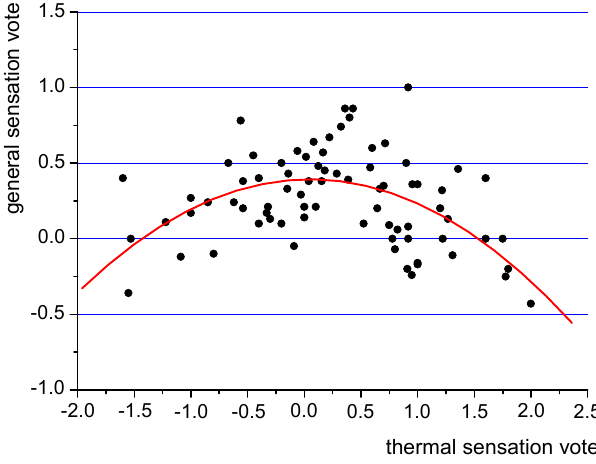
Figure 19. Average general sensation and thermal sensation votes based on 1369 questionnaires. General sensation vote above 0 indicates the positive assessment of the environmental